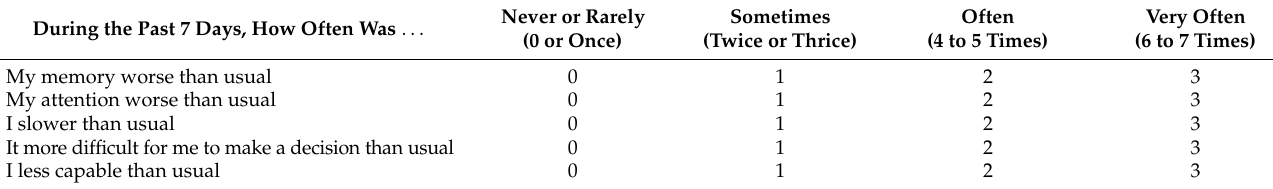
Table 1. Taiwan Cognition Questionnaire